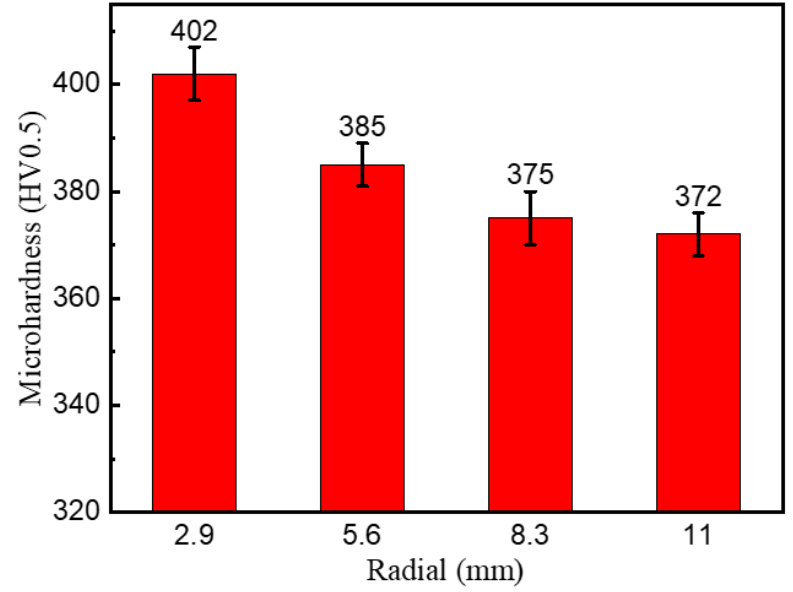
Figure 4. Microhardness of the forged tube with a reduction of 42.7%.